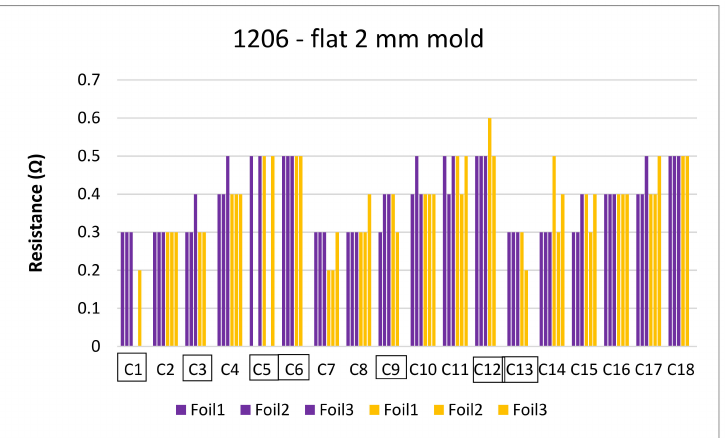
Figure 28. Resistance measurements for 1206 resistors molded in the 2 mm flat mold.